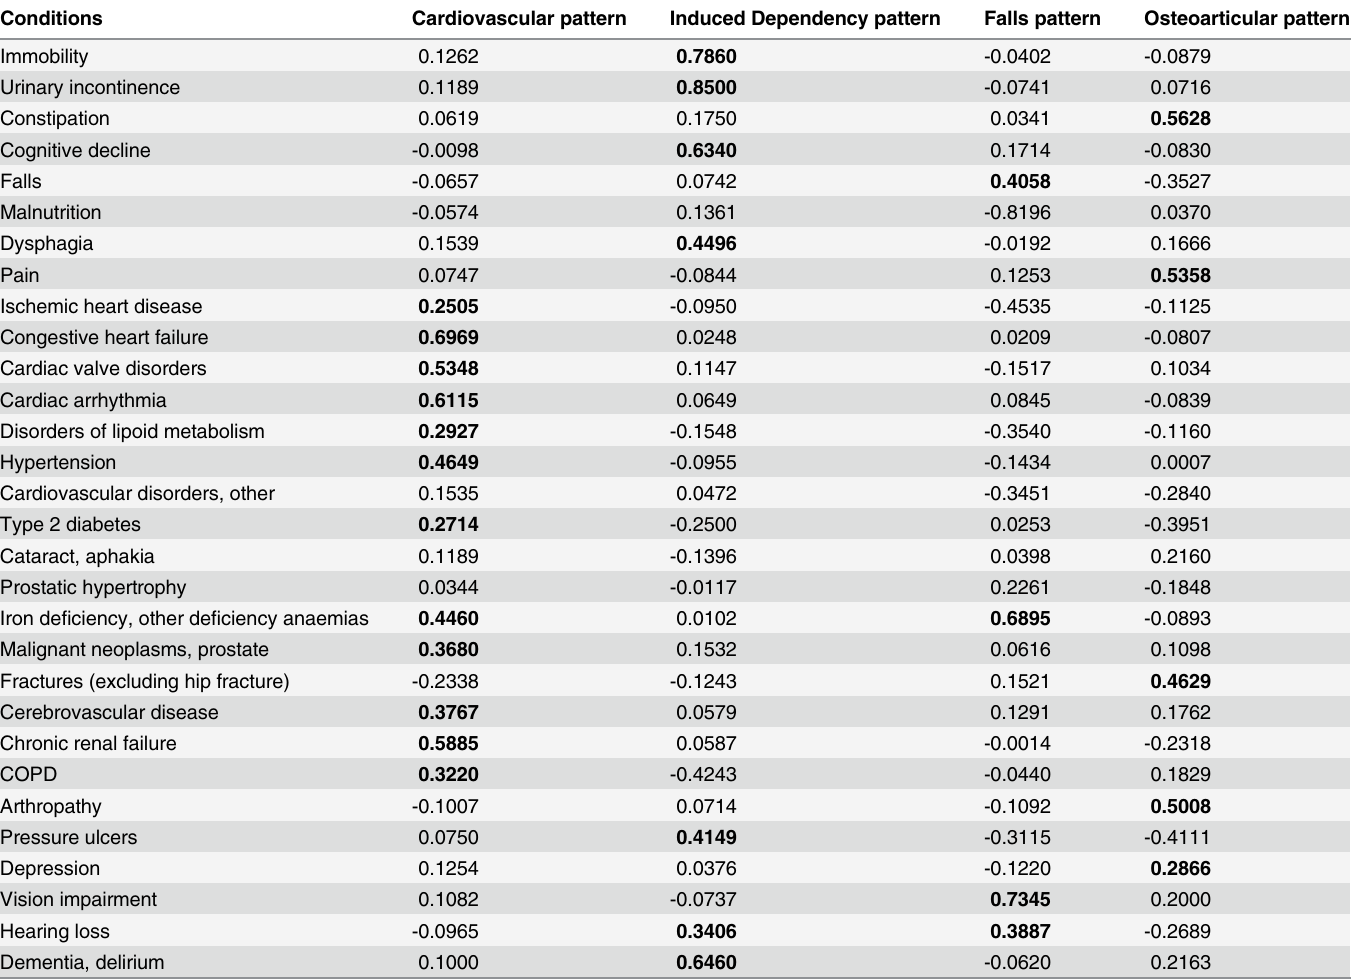
Table 3. Factor scores of the conditions included in each pattern in men. KMO: 0.56. Percentage of cumulative variance: 37.90%. Factors score > 0.25 are highlighted in